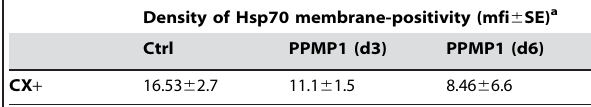
Table 3. Flow cytometric analysis of viable, 7-AAD- and Annexin-V-negative CX + tumor cells either untreated (Ctrl) or after treatment with a sublethal dose of 1 phenyl-2- hexadecanoyl amino-3-morpholino-1-propanol (PPMP1, 25 m M) for 3 or 6 days.